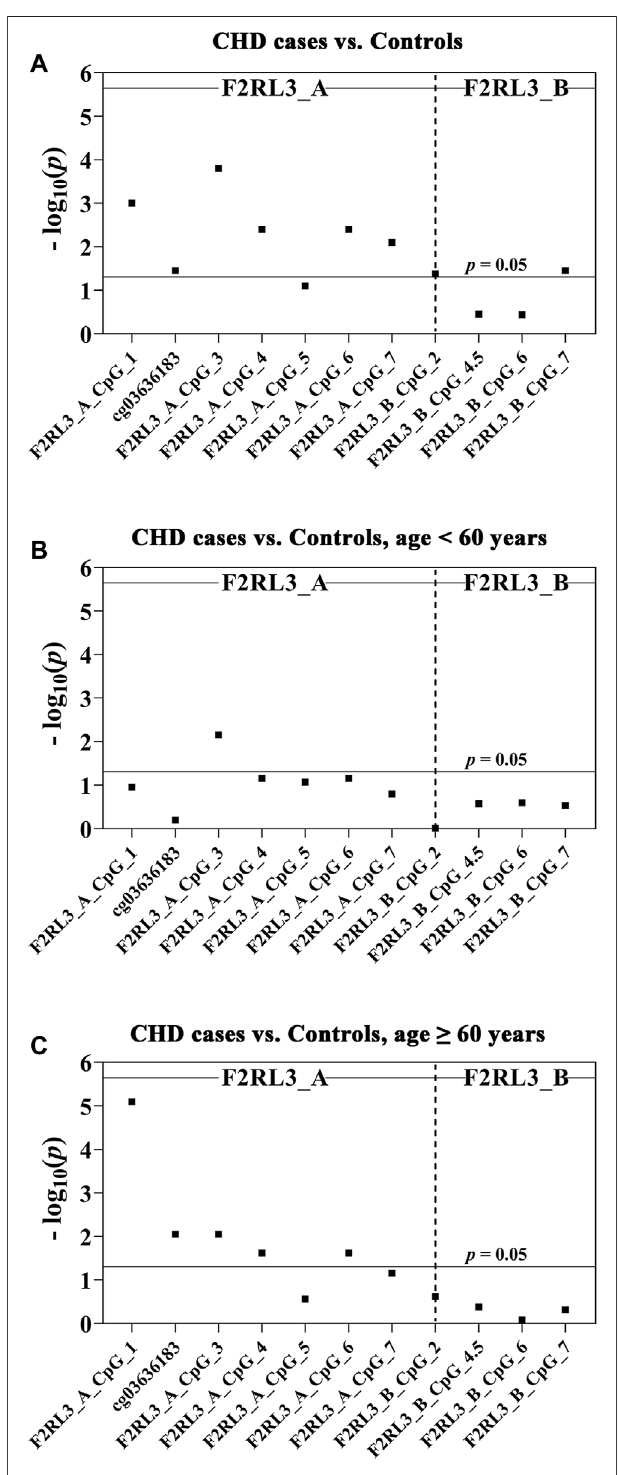
FIGURE 1 | The association between CHD and decreased F2RL3 methylation in the peripheral blood. The point plots show the methylation differences of CpG sites in the amplicon of F2RL3_A and F2RL3_B (A) between184controlsand180CHDcases, (B) between51controlsand 53 CHD cases, age < 60 years, (C) between 133 controls and 127 CHD